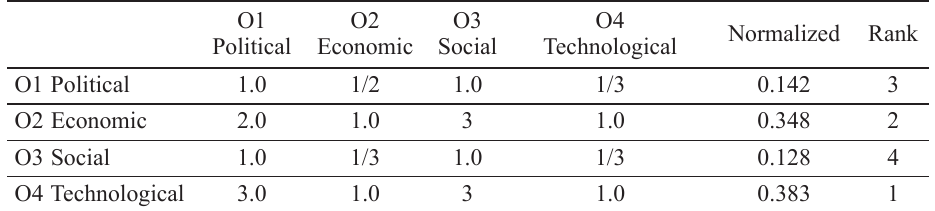
Table 6. Pair-wise comparison and determination of priorities in the line with the opportunities merit